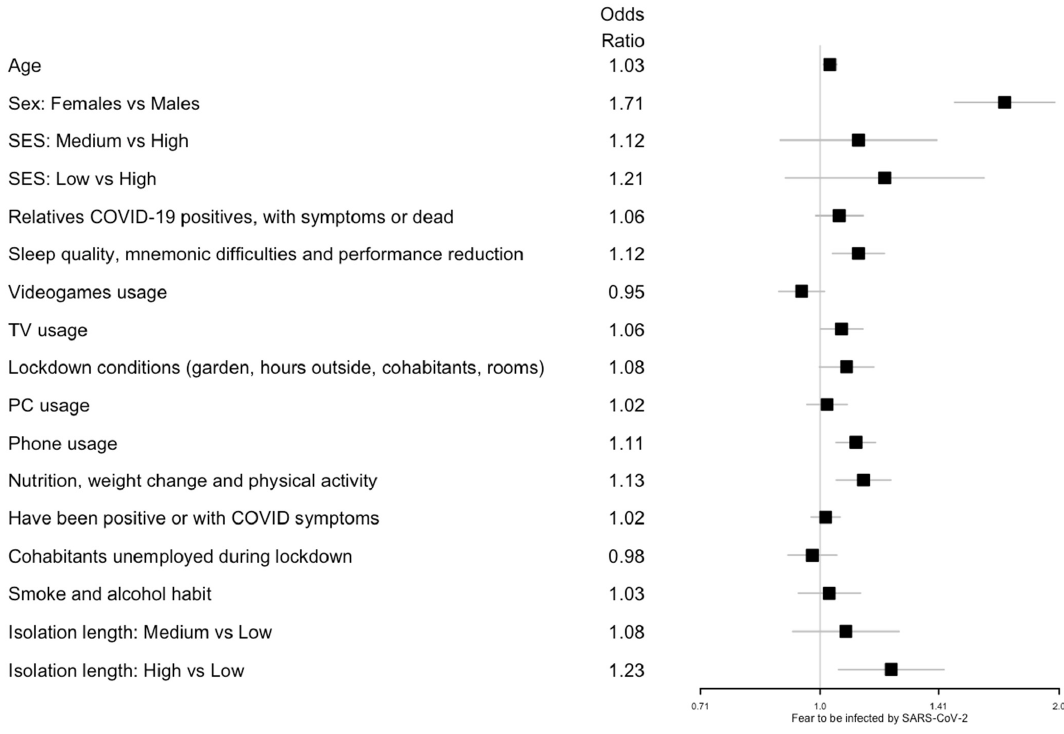
Figure 3. Forest plots for the effect of the covariates on fear of being infected by SARS-CoV-2. The squares represent the odds ratios and the lines depict the confidence intervals estimated by the ordinal logistic regression.